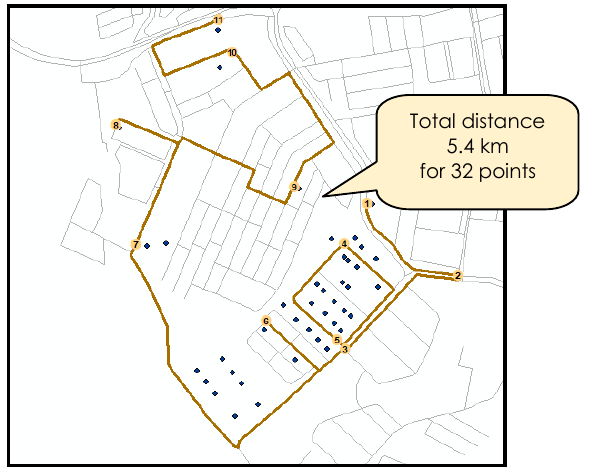
Figure 8 Total distance for Cluster 11